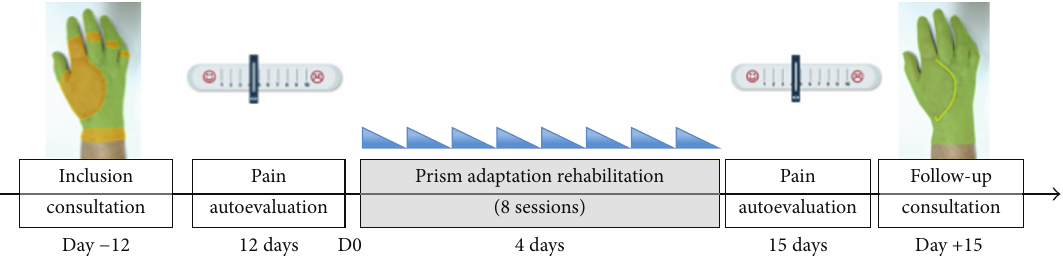
Figure 1: Global time chart. Patients were seen at around day − 12 for inclusion, and then pain autoevaluation was performed during a period of about 12 days, followed by 4 days of prism adaptation and then pain autoevaluation during a period of about 15 days, and they were then seen at follow-up